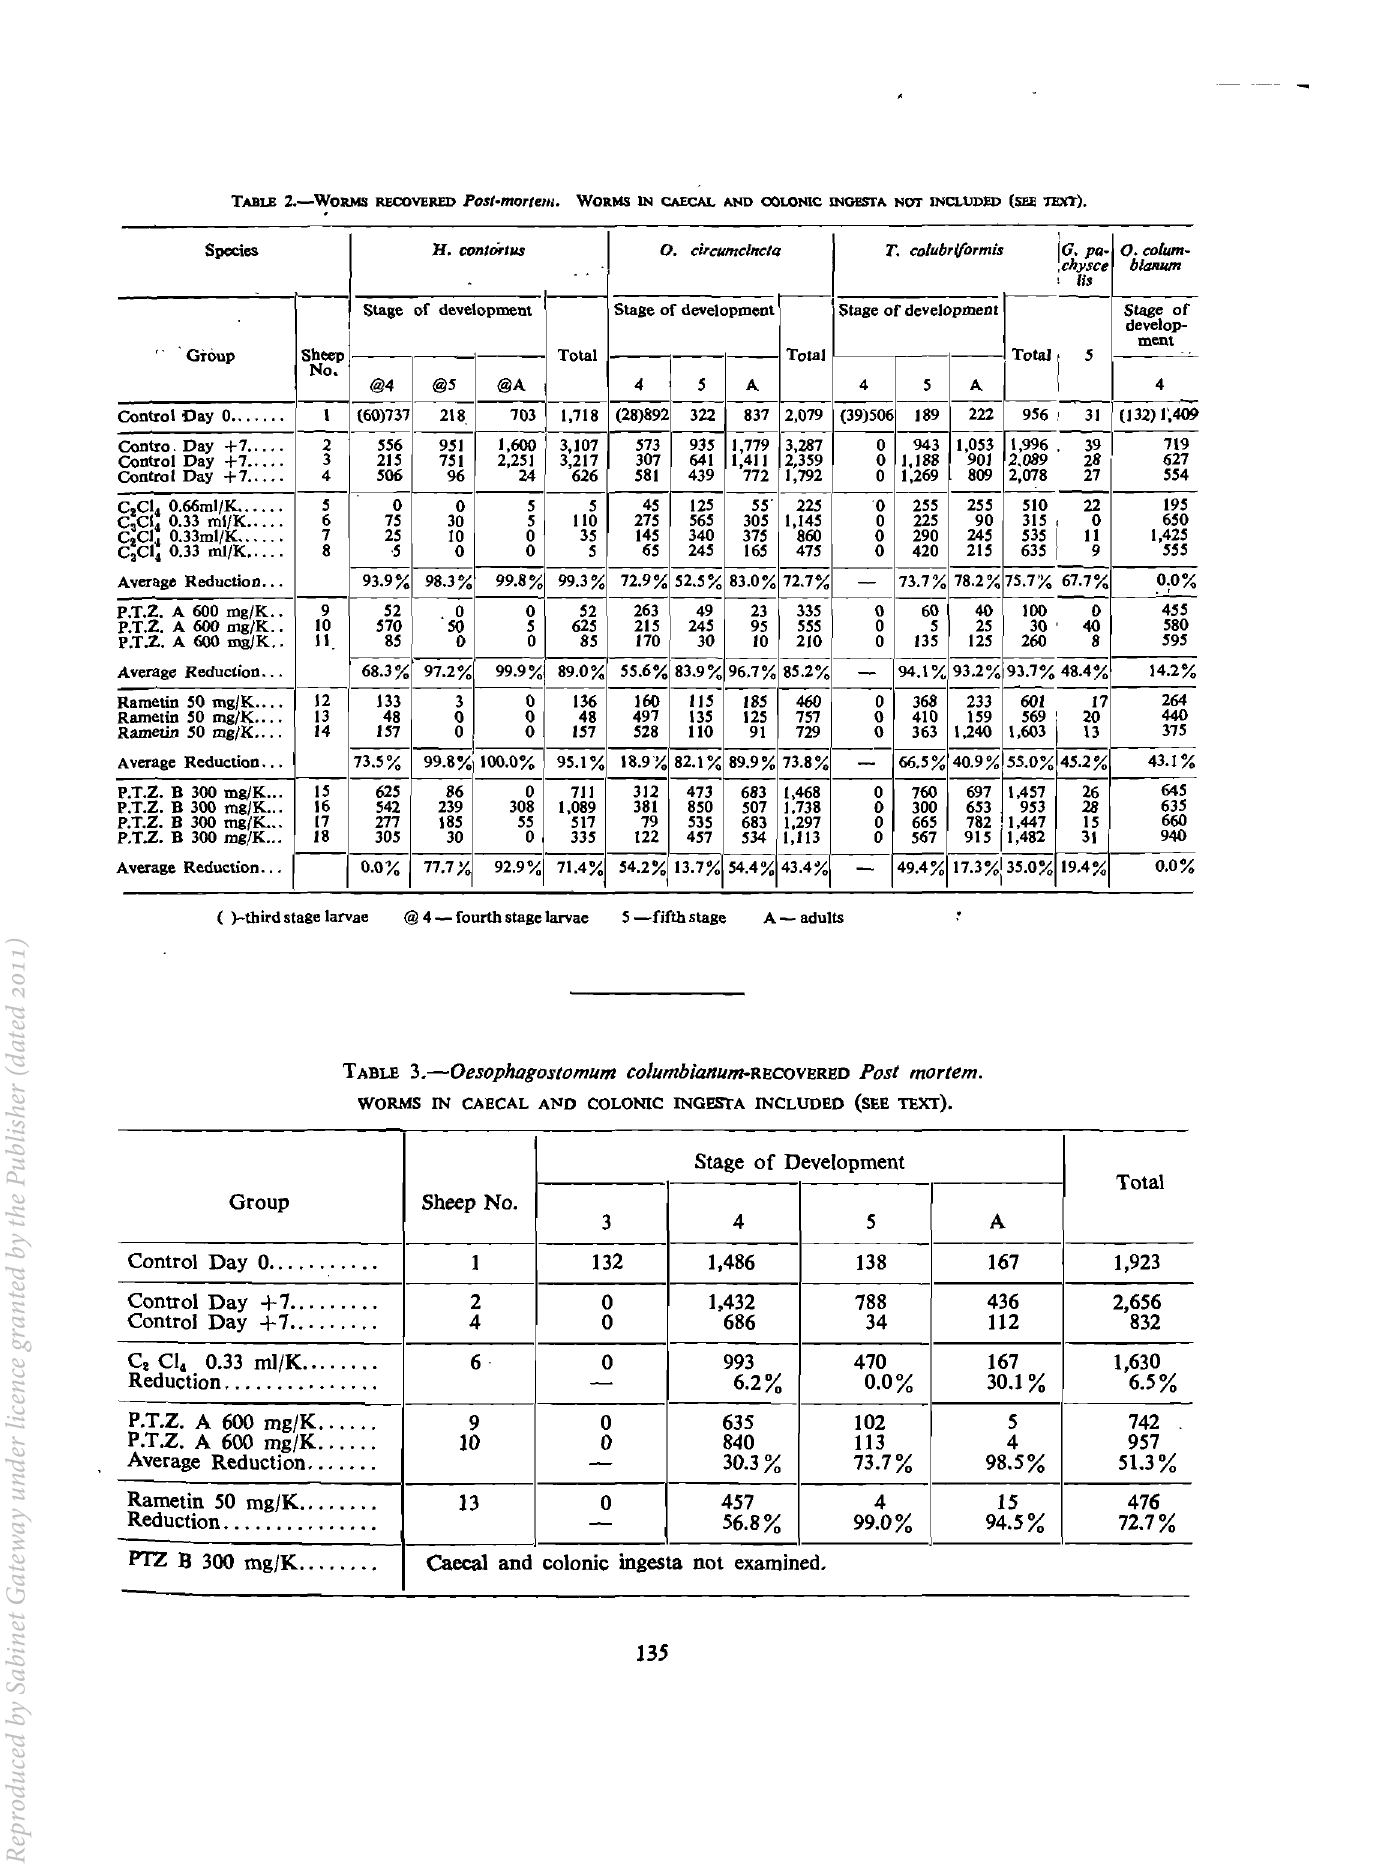
TABLE 2.-WORMS RECOVERED Pos/.mor/em. WORMS IN CAECAL AND COLONIC INGESTA N\1T INCLWID (SEll lEXT). H. Species C071/orlU3 T. colubriformis